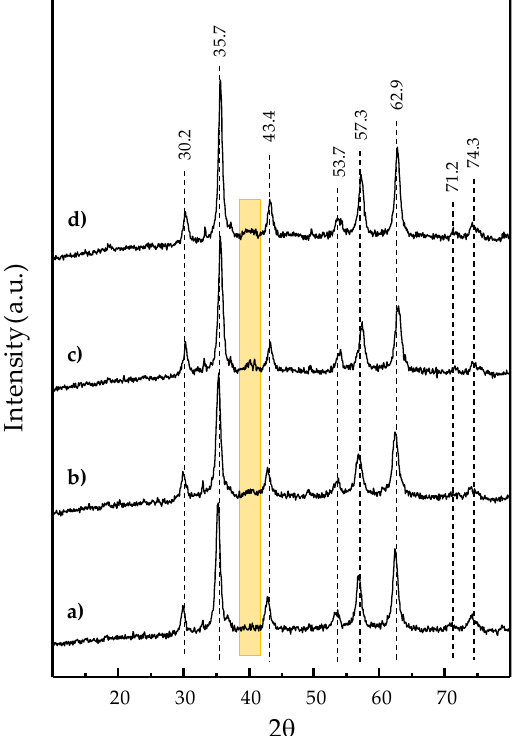
Figure 3. XRD patterns of nanocomposite catalysts based on magnetite (from 85 °C synthesis using Fe 3 + / Fe 2 + molar ratio of 4) doped with Pd or Pd - Ag: 1% Pd-Fe 3 O 4 ( a ), 2% Pd-Fe 3 O 4 ( b ), 3% Pd-Fe 3 O 4 ( c ), 3% AgPd-Fe 3 O 4 ( d ). Symbols: ( - - - ) Fe 3 O 4 (ICSD: 01-075-1609); the highlighted strip defines the region where the highest intensity di ff ractions for pure Pd, pure Ag, and AgPd alloys are found